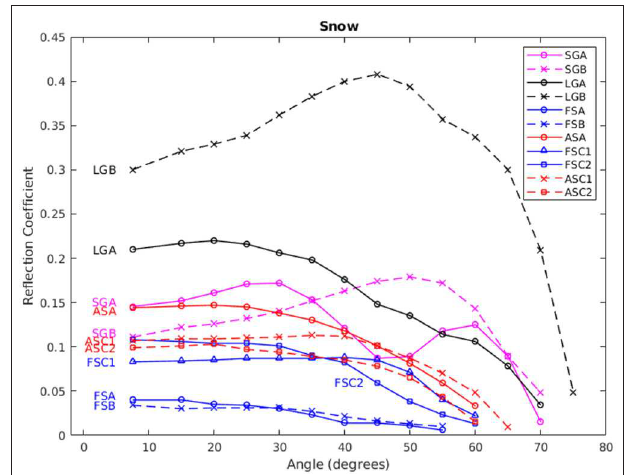
FIGURE 8 | Measured ultrasonic reflection coefficients as a function of incident angle for a variety of snow samples.